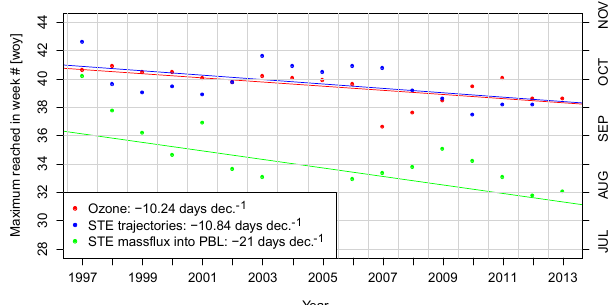
Figure 9. Time of year for which the maximum of ozone (red), STE trajectories (blue), and STE mass flux into the PBL (green) are reached. A 4-year sliding window of daily data was applied. Average values for the years 1996–1999 are shown as the data point at the end of December 1997, 1997–2000 at the end of December 1998, and so forth, until years 2012–2015, which are shown as data point at the end of December